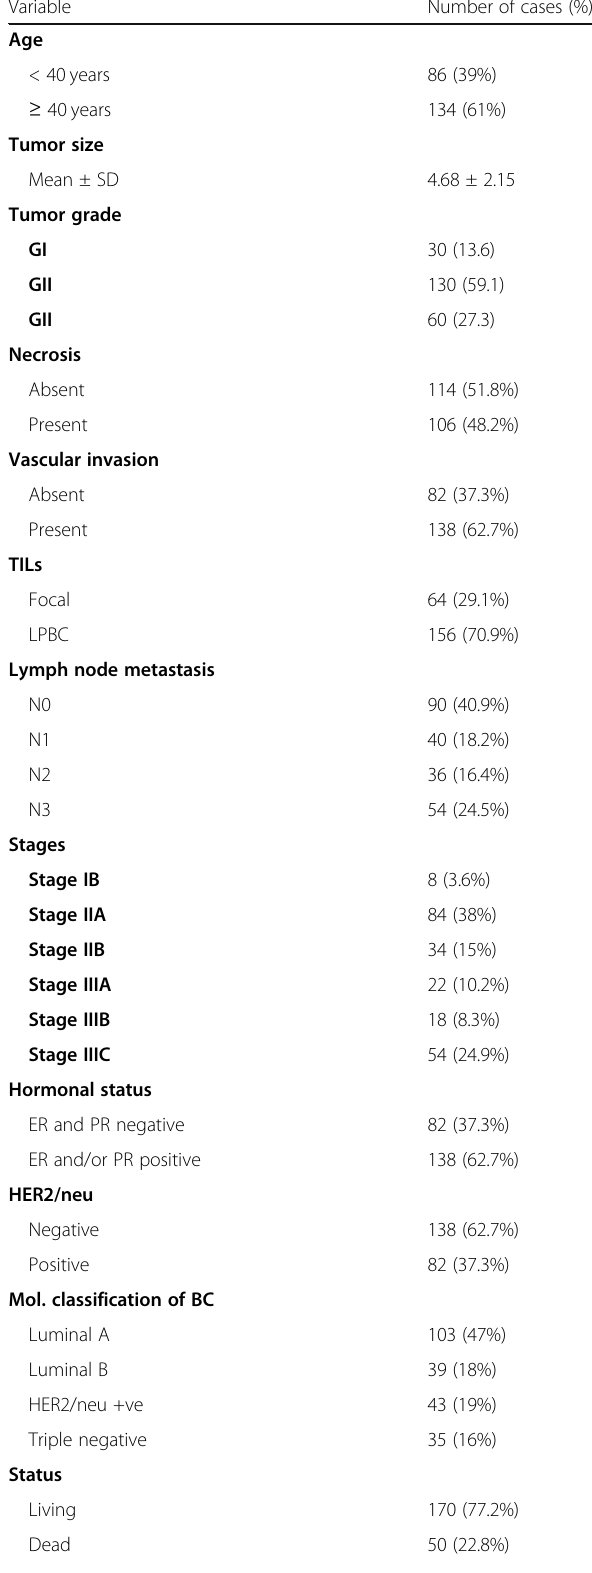
Table 1 Clinicopathological characteristics of the patients